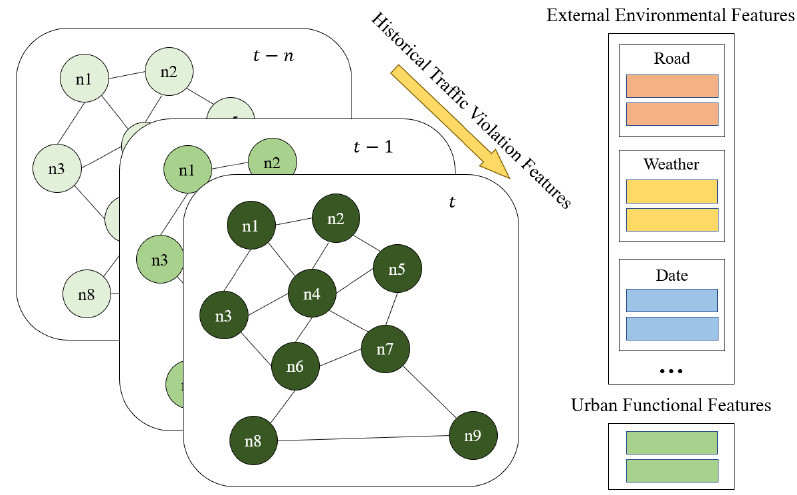
Figure 5. Feature set of traffic violations including historical traffic violation features, external environmental features and urban functional features.